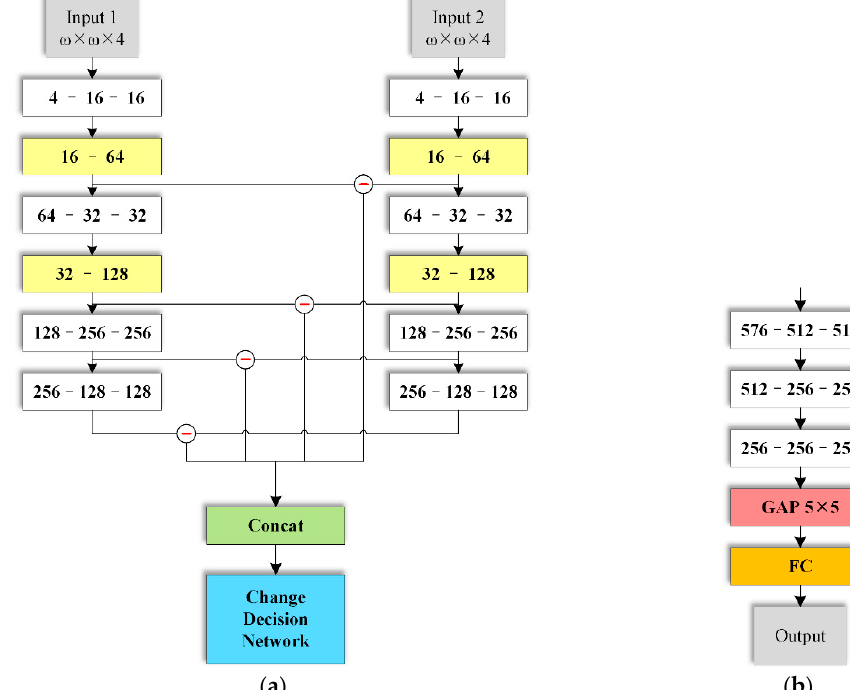
Figure 5. Illustration of the designed Siamese architectures for change detection. ( a ) Schematics of the proposed architectures (DSCNH). ( b ) Architecture of change decision network. Block color legend: White means normal convolution with kernel size 3 × 3, yellow means the proposed HCFEM, green means concatenation, blue means the Change Decision Network, red means Global Average Pooling layer, and orange means Fully Connected layer.